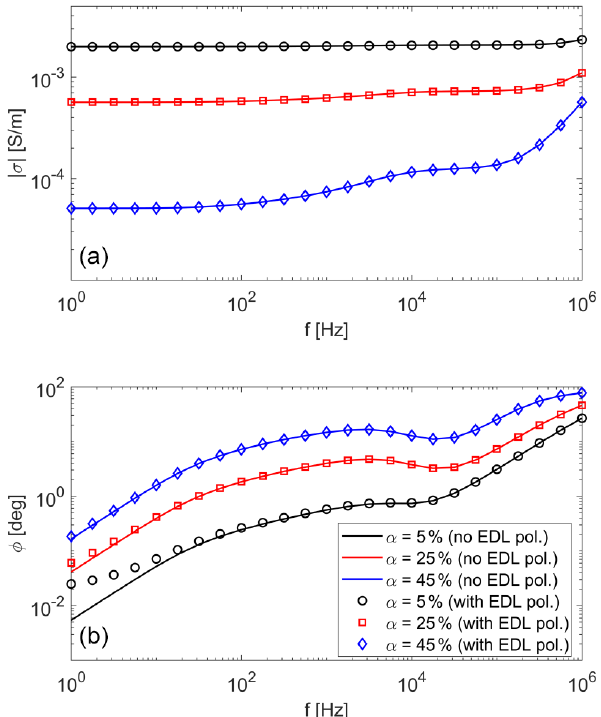
Figure 1. Magnitude (a) and phase shift (b) of the com- plex electrical conductivity vs. frequency for different ice con- tents α . The lines denote the simulation without EDL polar- ization, calculated with Eqs. (2)–(4); the symbols were calcu- lated using the extended form of Eq. (3) given by Eq. (5). The parameters in Eq. (5) are φ = 0 . 5, ρ g = 2650kgm − 3 , σ W = 0 . 1Sm − 1 , CEC = 18 . 8meq100g − 1 , B = 3 × 10 − 9 m 2 V − 1 s − 1 , λ = 3 × 10 − 10 m 2 V − 1 s − 1 , d = 8 . 5, and the parameters of the ice relaxation are ε m = 20, σ i , DC = 10 − 7 Sm − 1 , ε i , DC = 92, ε i , HF = 3 . 2, τ i = 2 . 2 × 10 − 5 s, c = 1, k = 1 3